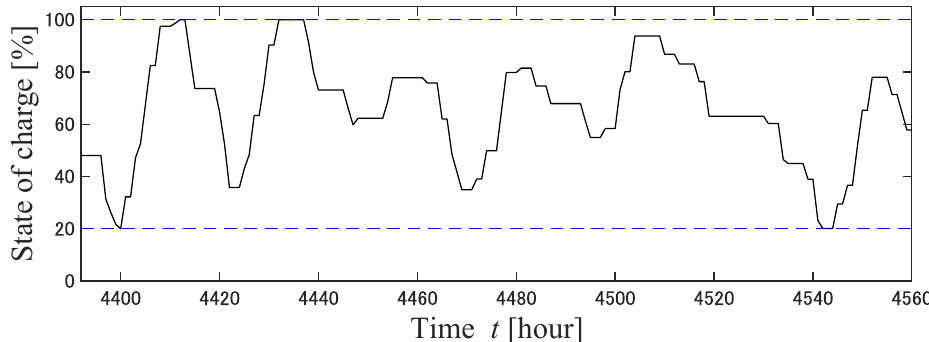
Figure 27. SOC of BESS from October 1 to 7 (Case 2).